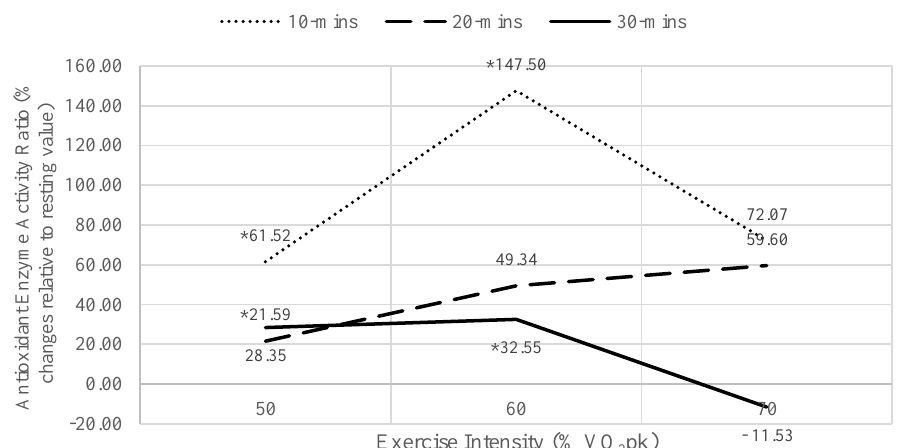
Figure 4. Percentage of SOD changes at 50%, 60%, and 70% V̇ O 2 pk during exercise. * significantly different from 70% V̇ O 2 pk ( p < 0.05).